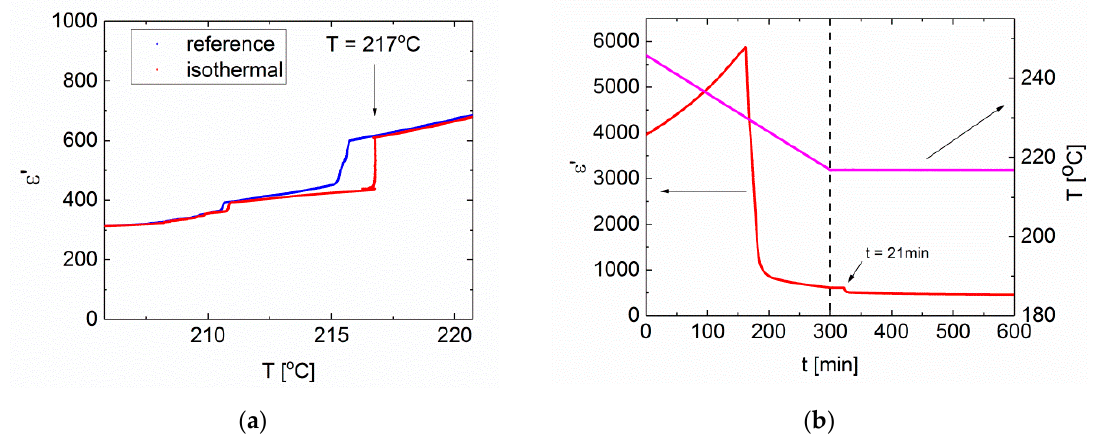
Figure 9. ( a ) Dielectric changes for the reference ε (T) run (blue curve) and ε (T) run (red) after keeping the sample at 217 ° C for 21 min (red); ( b ) Changes of permittivity (red) and temperature (pink) as a function of time [36].